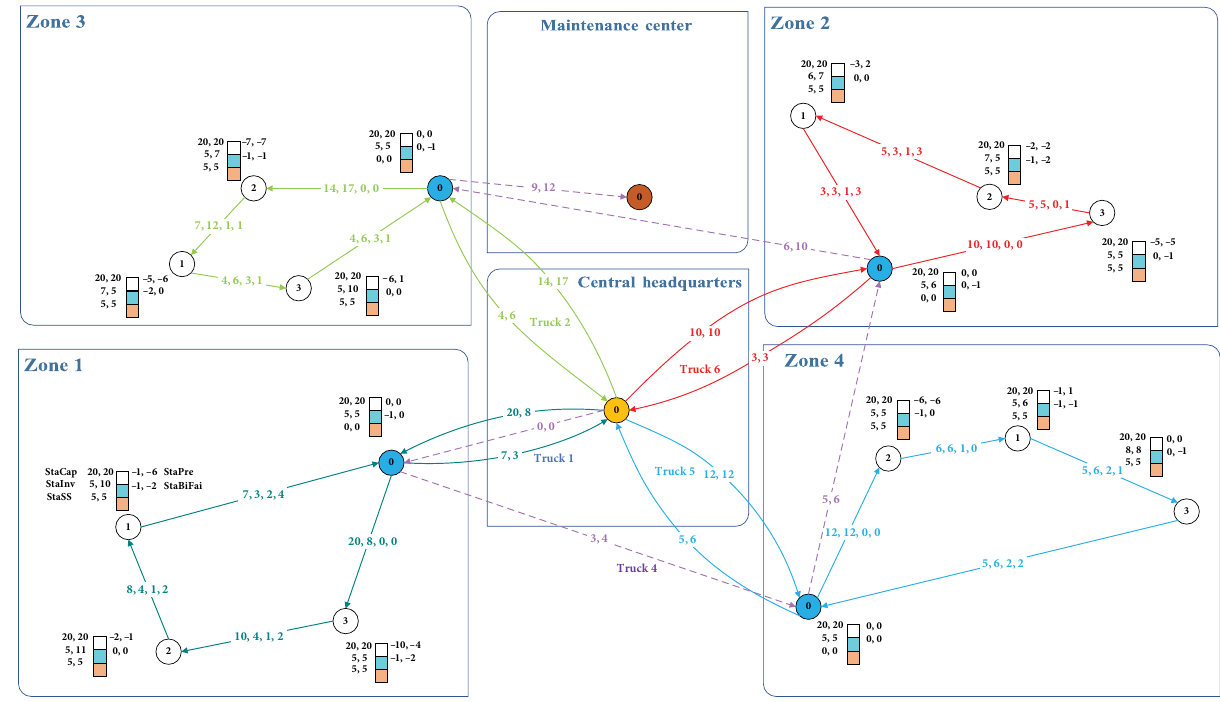
Figure 4. Result of solving numerical example